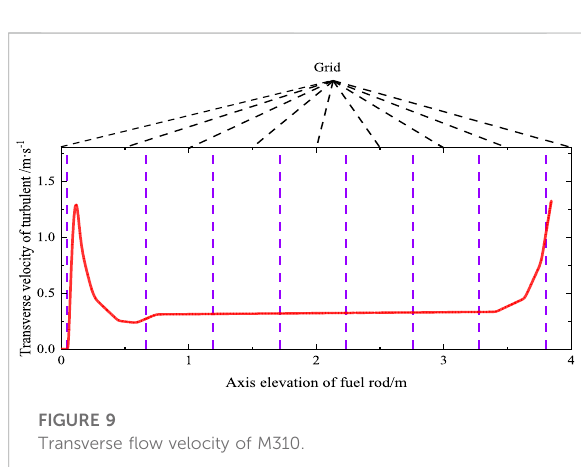
FIGURE 9 Transverse fl ow velocity of